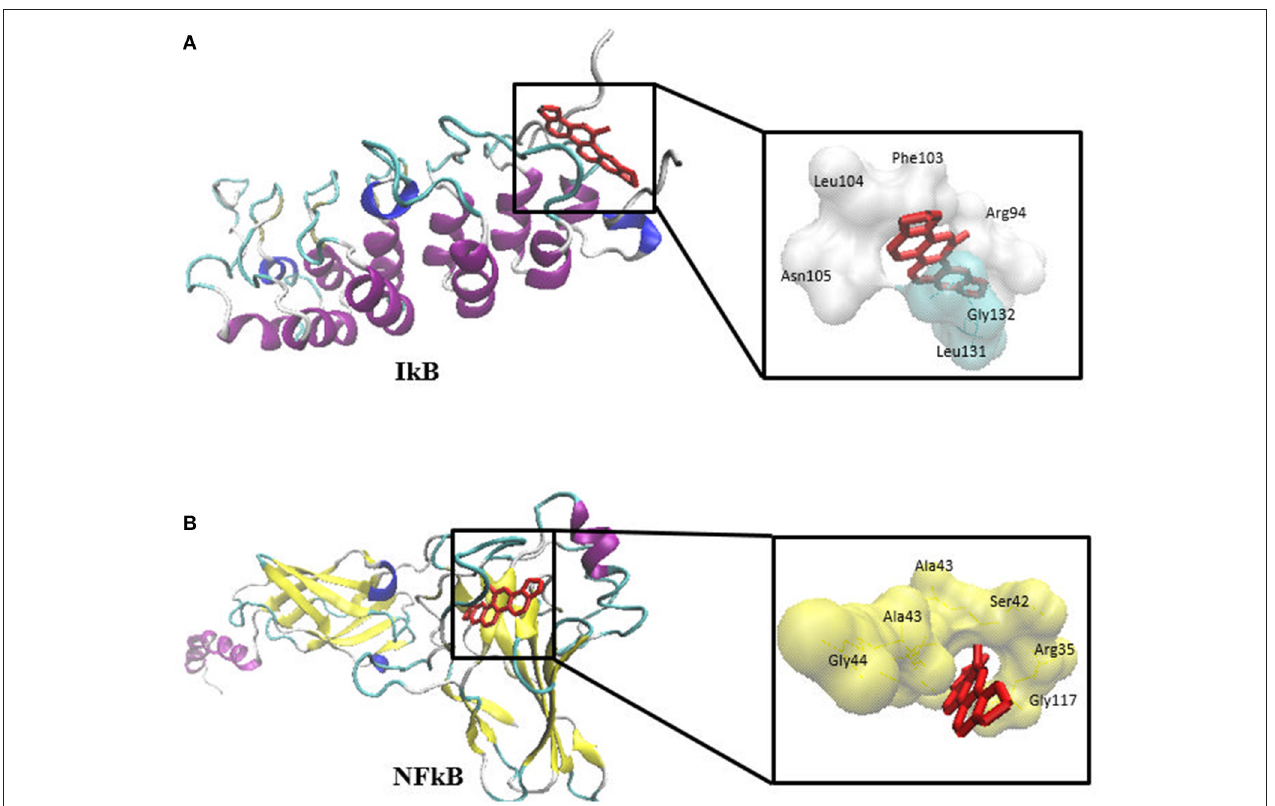
FIGURE 6 | Molecular docking of sanguinarine to (A) I κ B and (B) NF- κ B proteins.